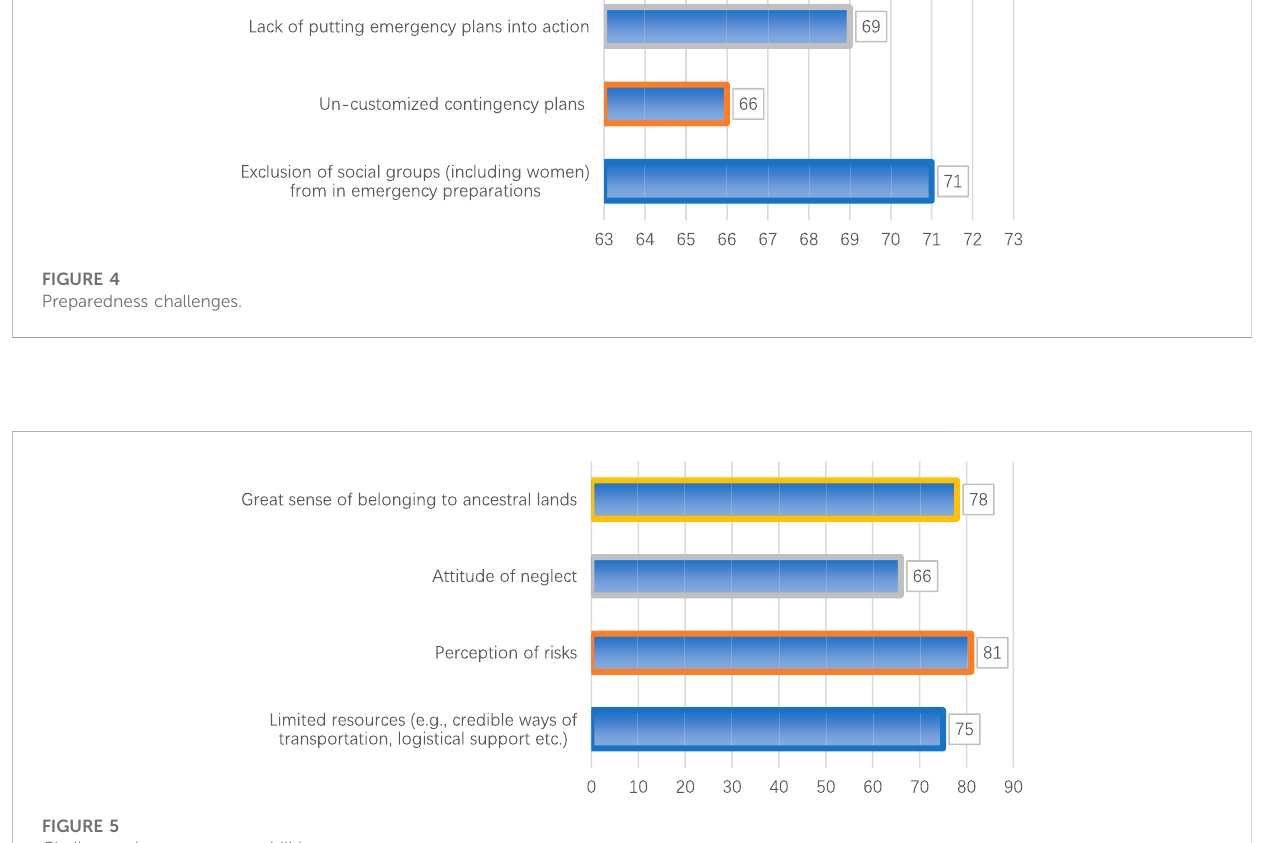
FIGURE 5 Challenges in response capabilities.